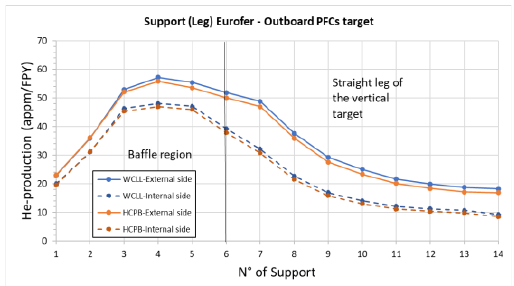
Figure 48. Inner poloidal profiles of the He-production (appm/FPY) on PFC-CB supports made of Eurofer, comparing the values on the external and the innermost target sides, both for WCLL and HCPB blanket case.